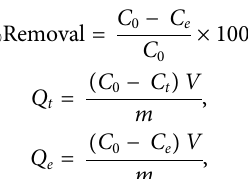
thermogravimetric (TG) curves of PFPC and PFPCS. Two-stage weight losses can be observed for PFPC, whereas PFPCS shows three-stage weight losses process. The fi rst stage of weight loss at